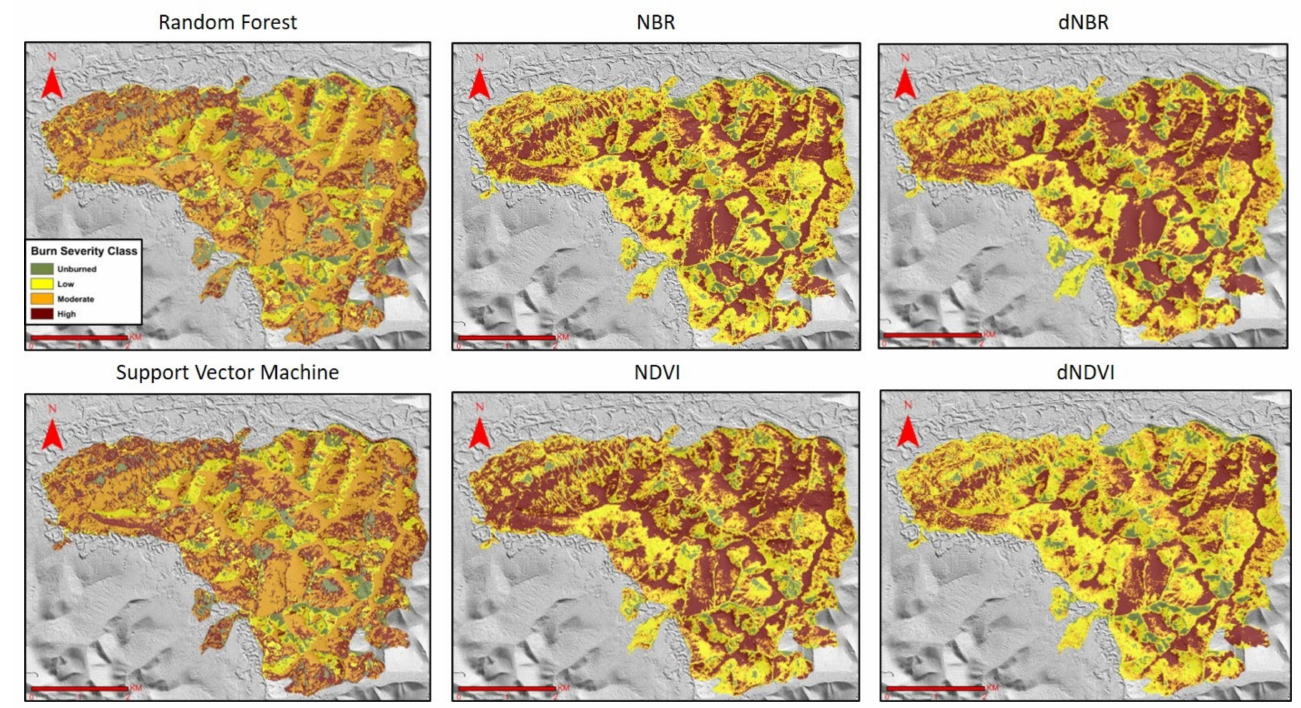
Figure 5. Comparison of the Nugget Creek burn severity map products.